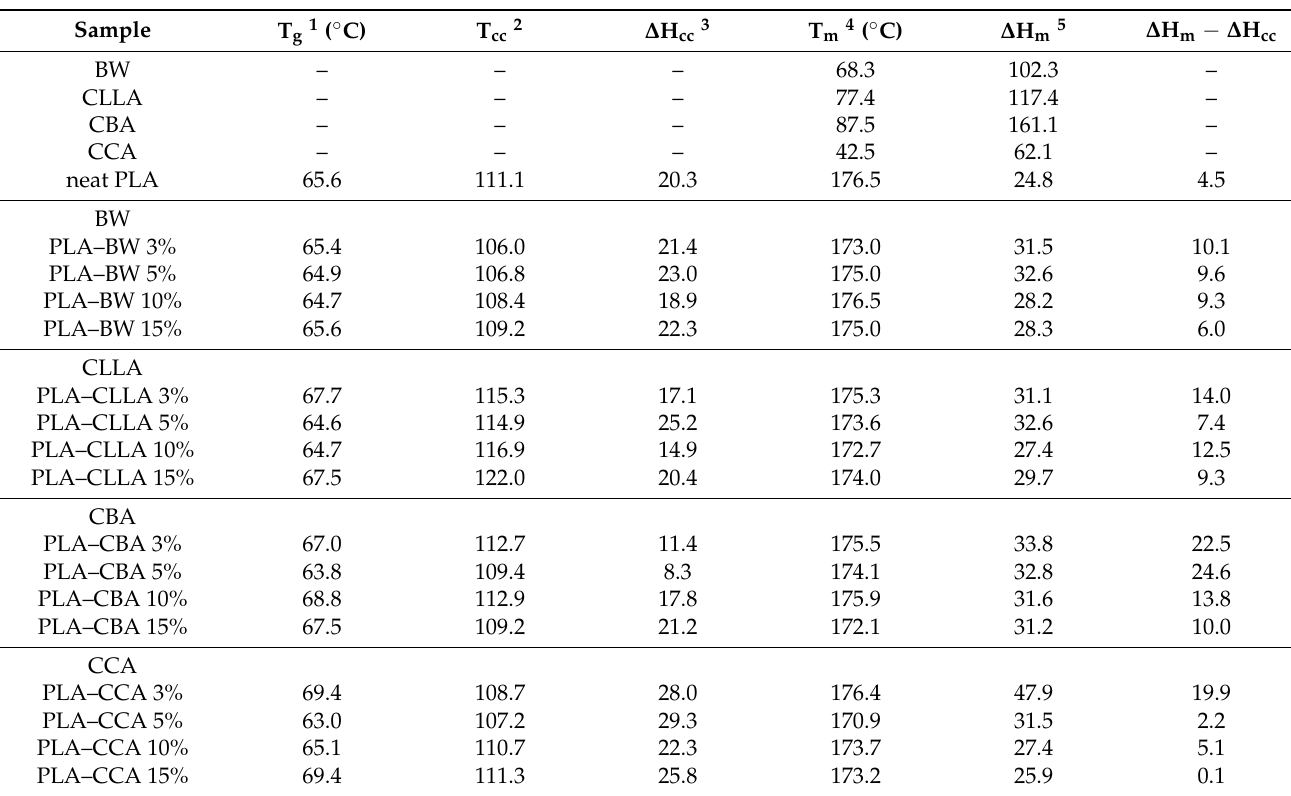
Table 2. DSC data from 1st scan of neat PLA; BW; CLLA; CBA; CCA; PLA–BW (3, 5, 10, and 15 wt%); PLA–CLLA (3, 5, 10, and 15 wt%); PLA–CBA (3, 5, 10, and 15 wt%); and PLA–CCA (3, 5, 10, and 15